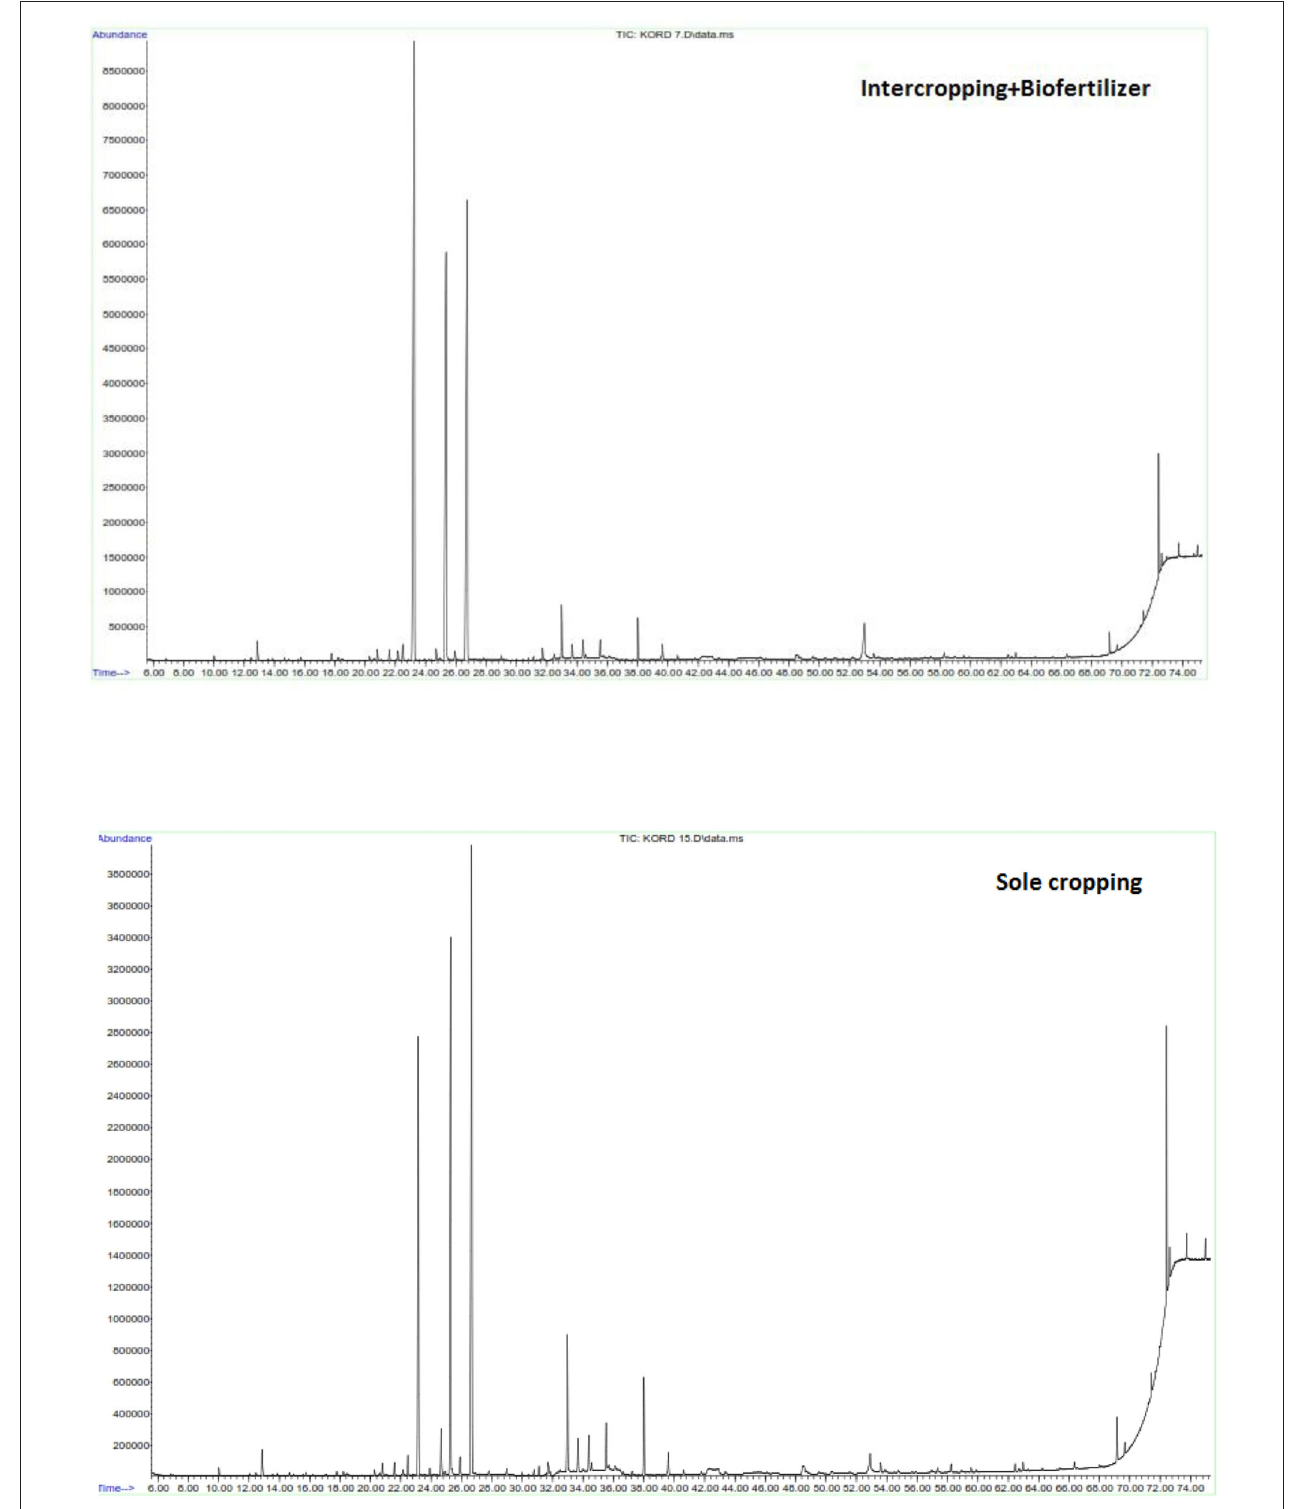
FIGURE 5 | Ocimum basilicum L. essential oil chromatogram carried out using a GC-MS. Essential oils were obtained from non-biofertilizer with Azospirillum brasilense and Azotobacter chroococcum application and sole and intercropped plants.